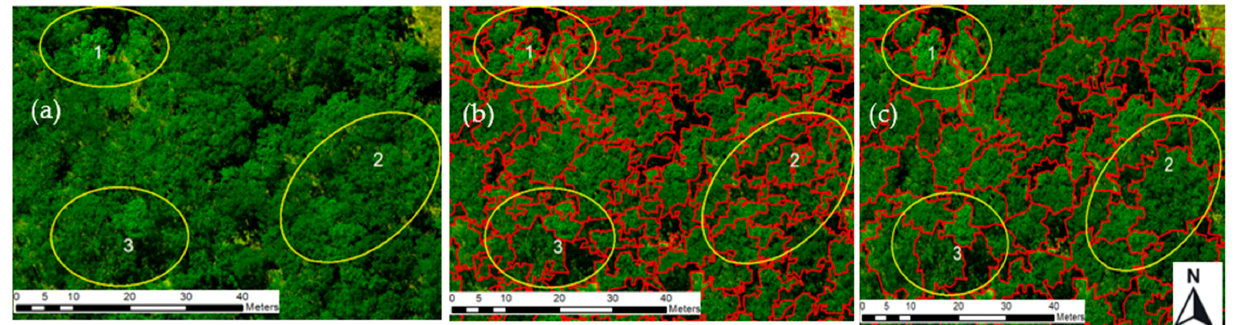
Figure 4. Visual comparison of segmentation using orthophoto alone vs. orthophoto with CHM at highlighted sites 1–3: ( a ) Original orthophoto; ( b ) using only the orthophoto, over-segmentation with irregular outlines for tree crowns; and ( c ) using orthophoto and CHM, tree crowns are well segmented with smoother outlines.